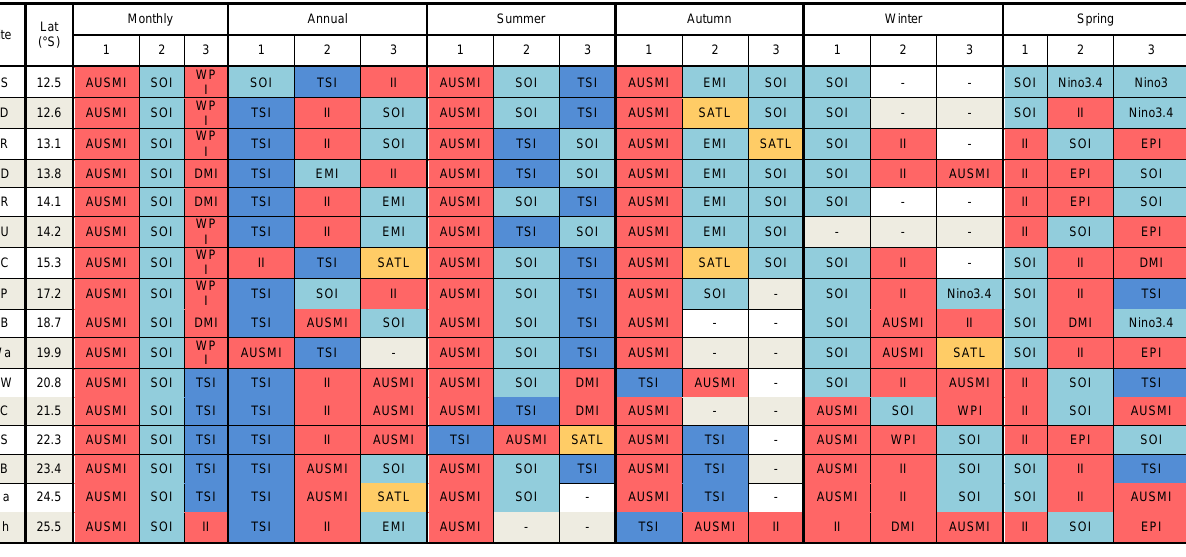
Table 4. Table shows the first three most highly correlated indices with rainfall at each site over the NATT (Table 1) for the period 1900 to 2010. Correlations are shown using the monthly data and interannual correlations are provided using the annual data. In addition, annual correlations are computed for the individual seasons only. Only correlations significant at the 95% level are shown. Superscripts represent in which region the climate index is located and are defined as follows: IND is Indonesia and Indian Ocean, PAC is Pacific Ocean, TAS is Tasman Sea, and ATL is Atlantic and Tropical ocean. The first column for each time period in this table (i.e. the “1” columns) are shown in Fig. 5.